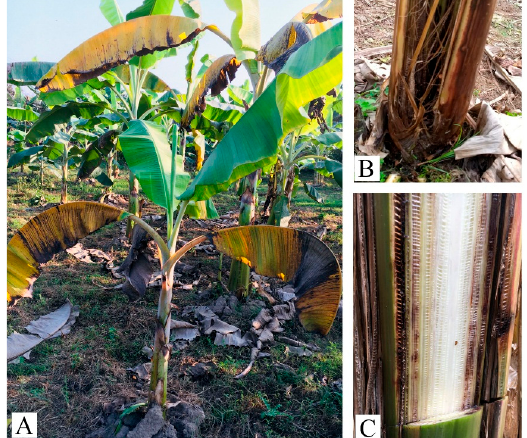
Figure 1. Different diseased plants (Malbhog variety) with various symptoms on different parts in the Chitwan district. ( A ) Whole plant, ( B ) splitting pseudostem, and ( C ) reddish to dark-brownish discoloration of the vascular